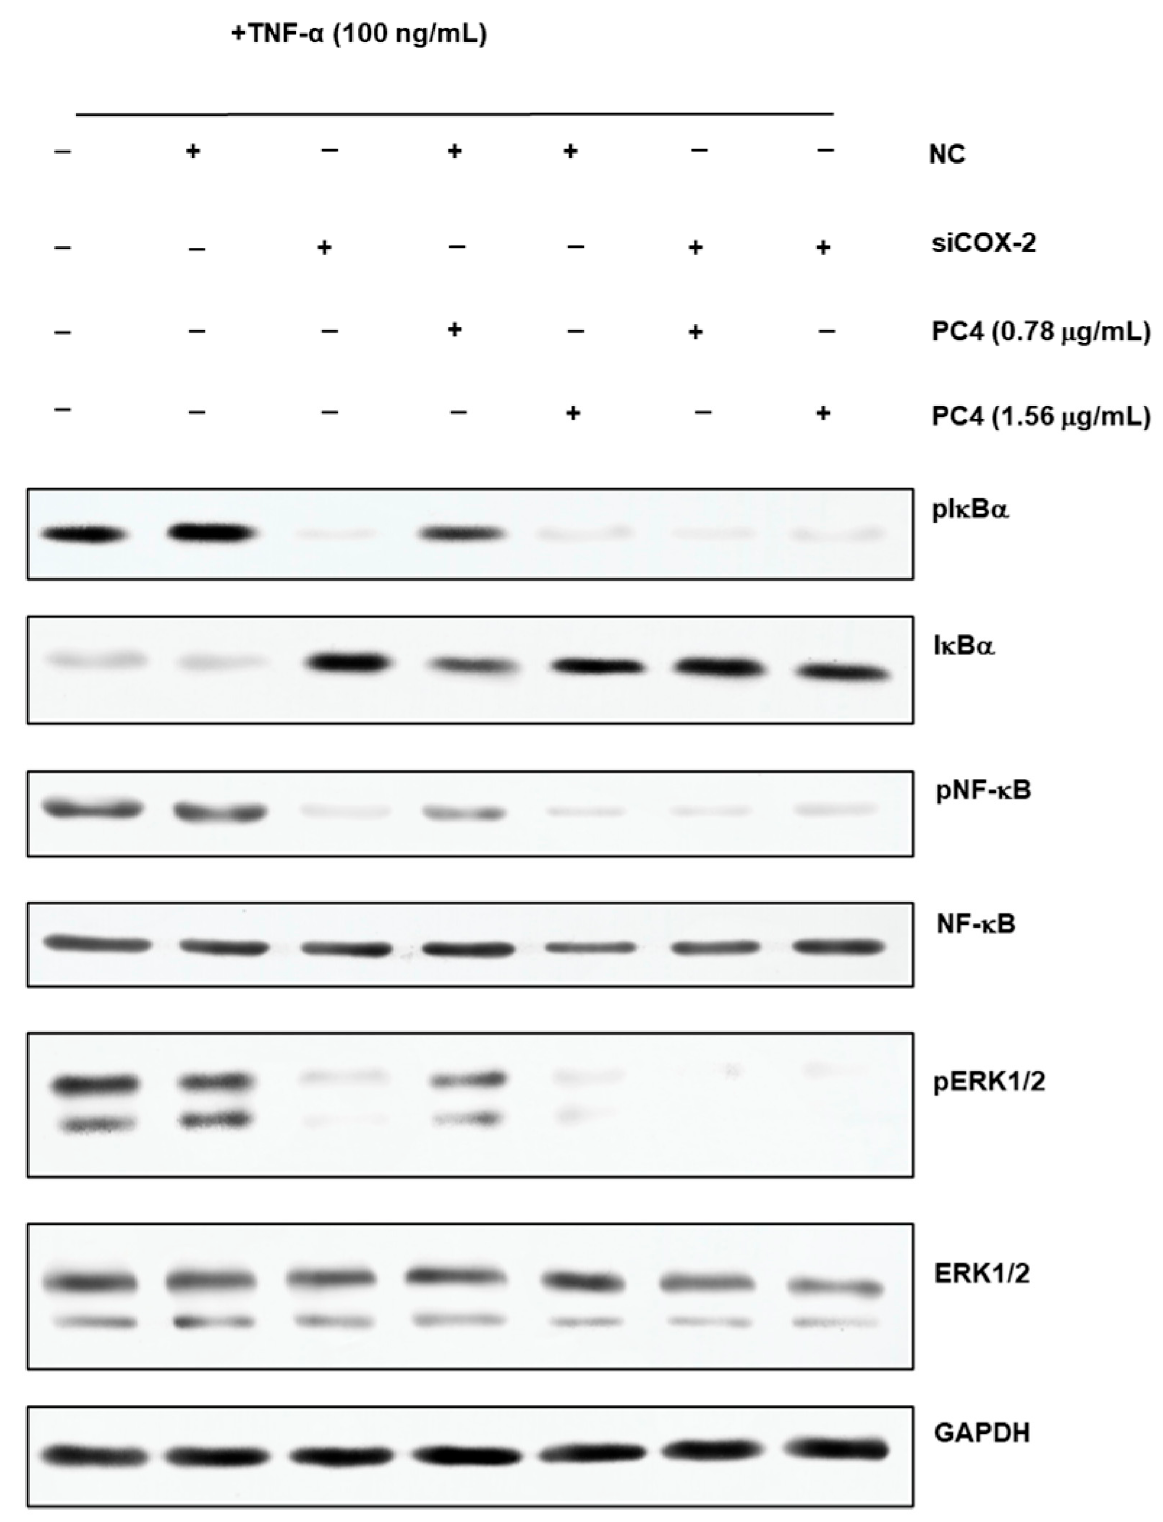
Figure 6. Western blot images of phosphorylation nuclear factor kappa-B inhibitor alpha (pIkB α ), phosphorylation nuclear factor kappa-B (pNF- κ B), phosphorylation extracellular signal-regulated kinase 1/2 (pERK1/2), IkB α , NF- κ B, ERK1/2 and glyceraldehyde-3-phosphate dehydrogenase (GAPDH). +means added, and − means not added. NC means normal cell group, PC2 means hydroxy-2,4,7-trimethoxyphenanthrene and PC4 means 6,7-dihydroxy-2,4-dim